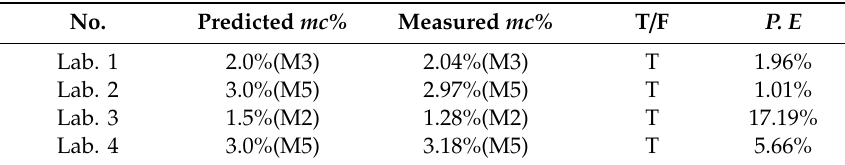
Table 8. Prediction results of the lab samples.